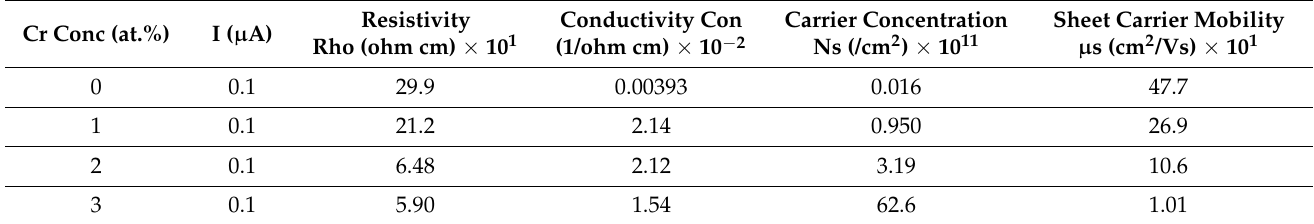
Figure 7. Dependence of ( a ) carrier concentration and ( b ) sheet carrier mobility on dopant concentration. Table 3. Hall studies of undoped and Cr-doped Bi 2 S 3 films.